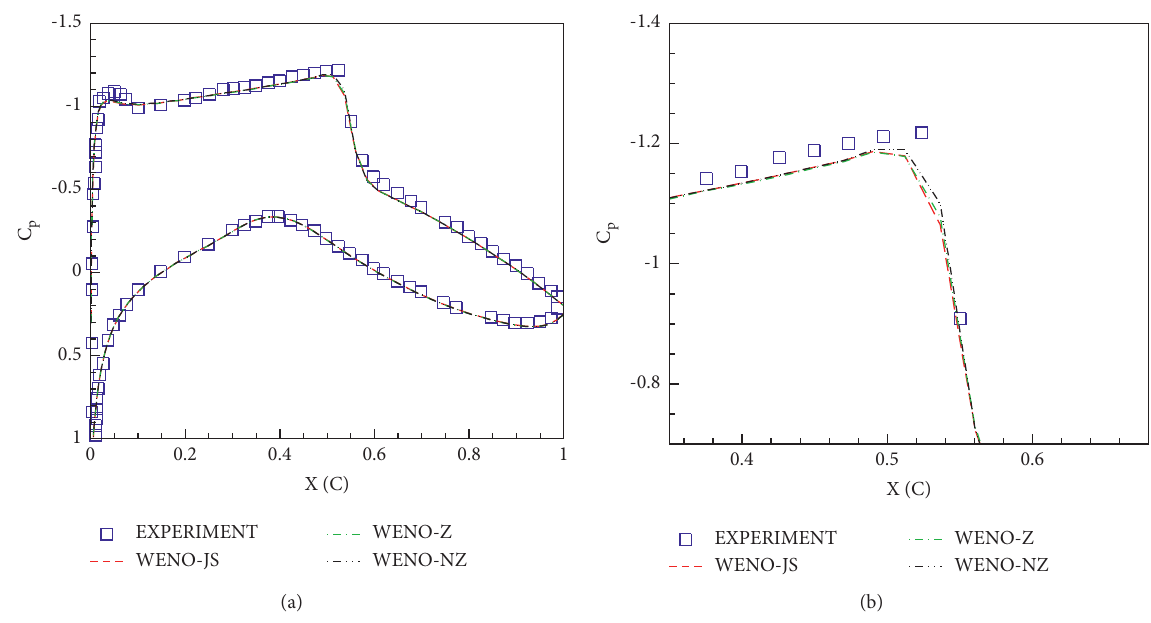
Figure 8: Pressure coefficients at the airfoil surface about the transonic flow for RAE2822 airfoil. (a) Full view. (b) Locally enlarged